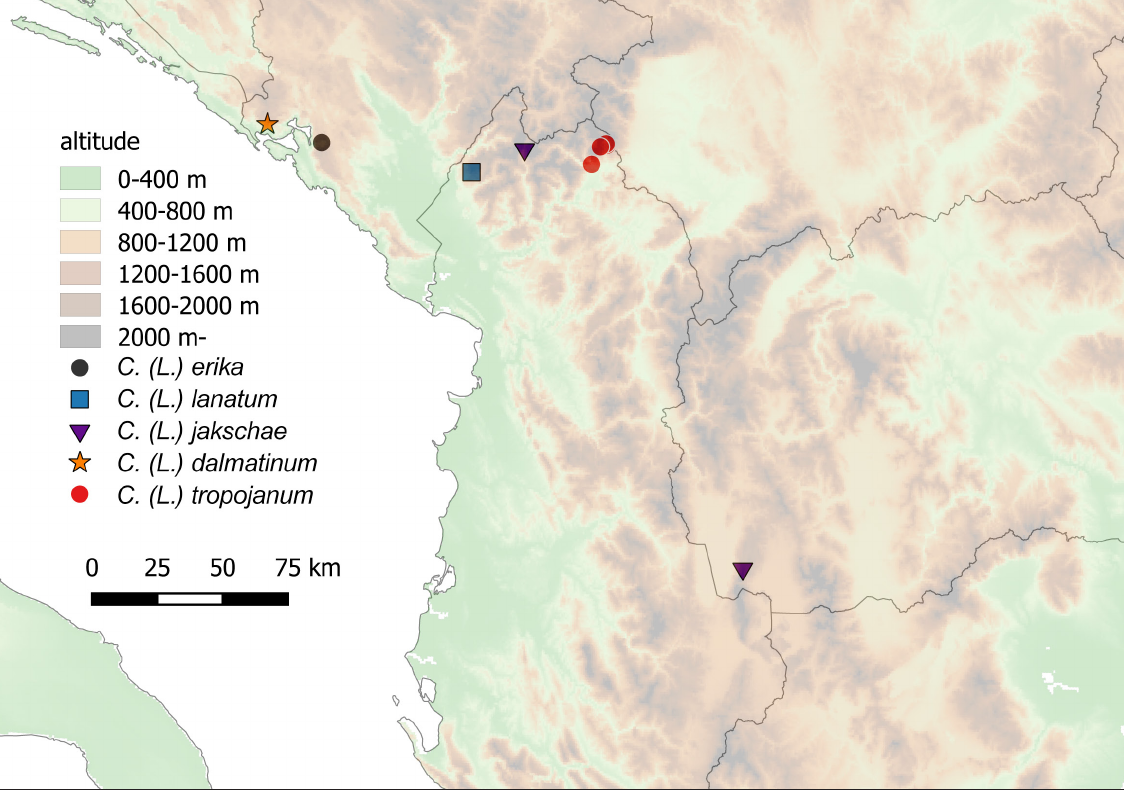
Fig. 1. Distribution of the species of Cochlostoma (Lovcenia) Zallot et al. , 2015 in the western part of the Balkan